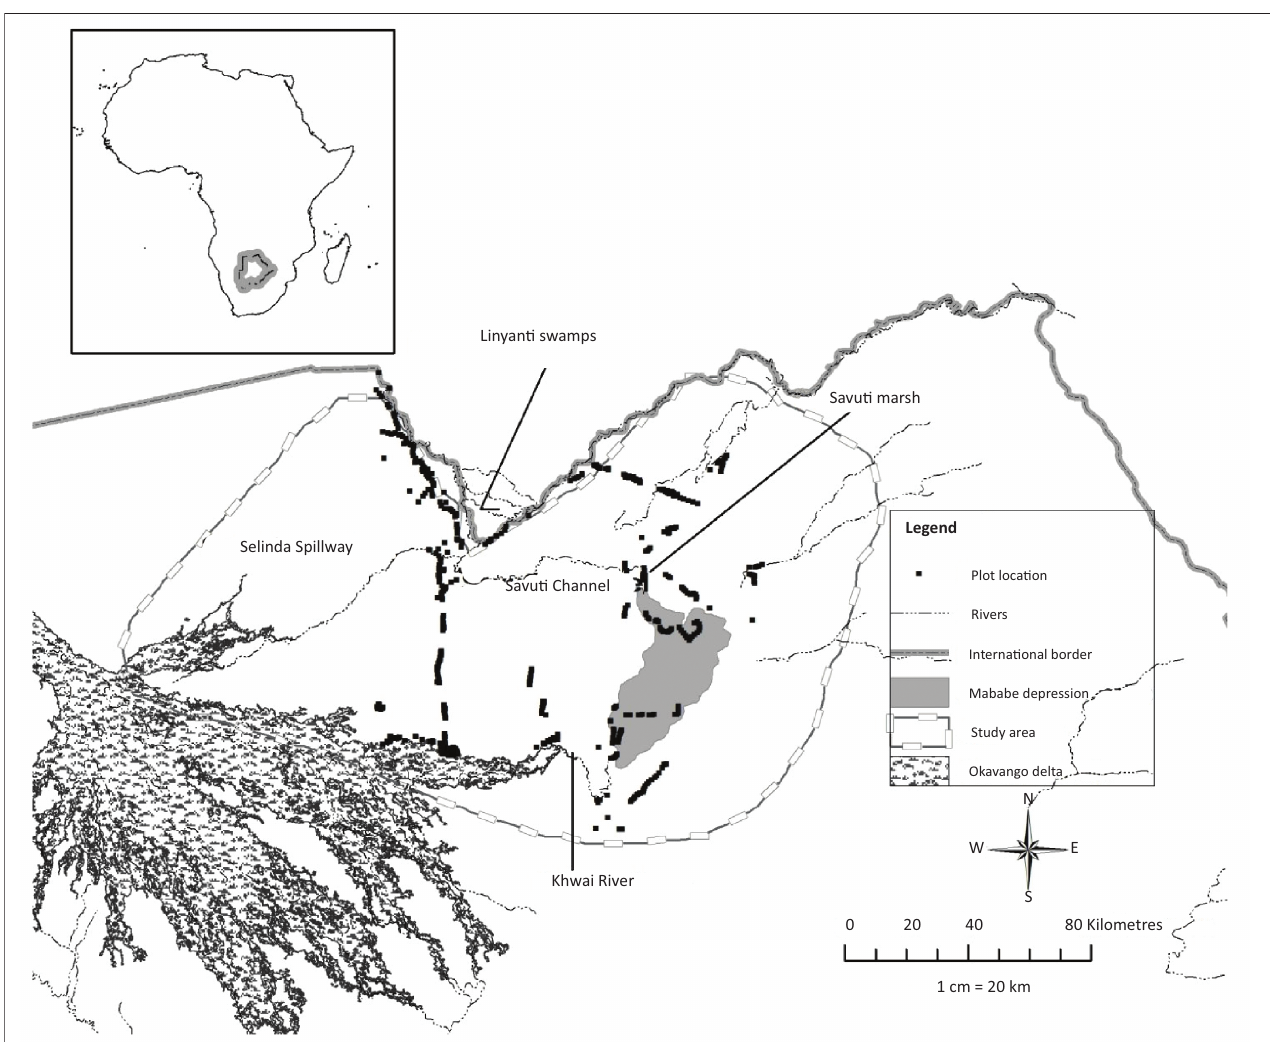
FIGURE 1: Study area depicting the Savuti-Mababe-Linyanti ecosystem and locations of sampling